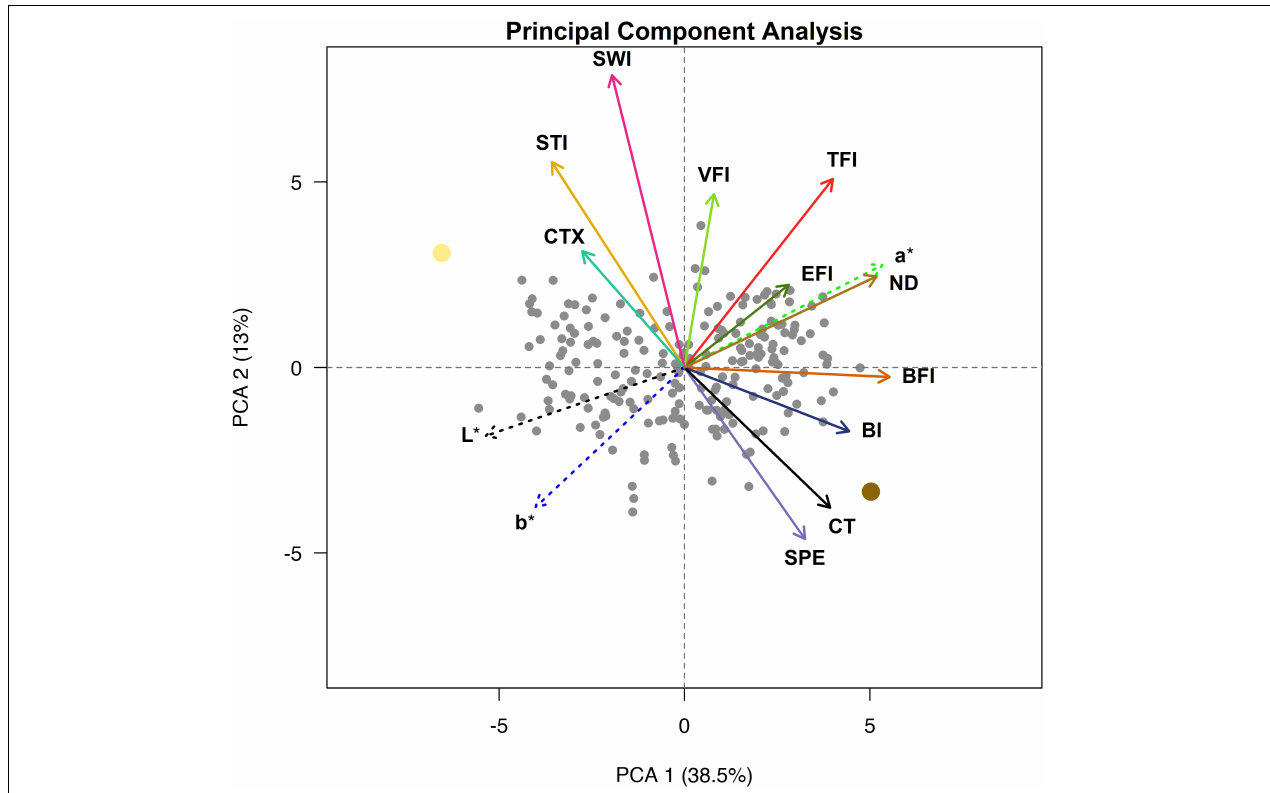
FIGURE 5 | Principal component analysis biplot with loadings for cooking time (CT), total flavor intensity (TFI), beany intensity (BFI), vegetative intensity (VFI), earthy intensity (EFI), starchy intensity (STI), sweet intensity (SWI), bitter intensity (BI), seed-coat perception (SPE), cotyledon texture (CTX), L*, a*, and b*. Ervilha and PI527538 are indicated in yellow and brown, respectively.